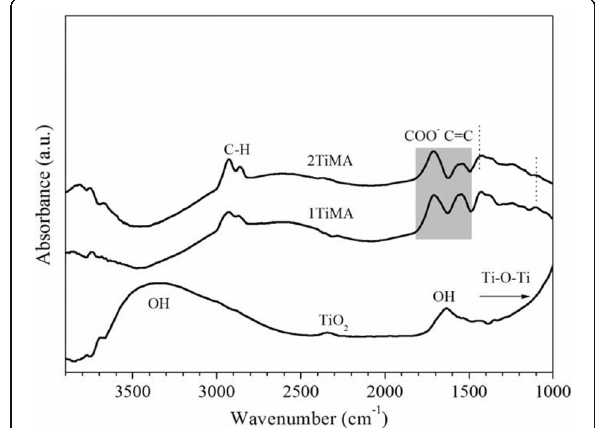
Fig. 4 FTIR spectra of TiO 2 , 1TiMA-ET, and 2TiMA-ET in the range from 4000 to 1000 cm